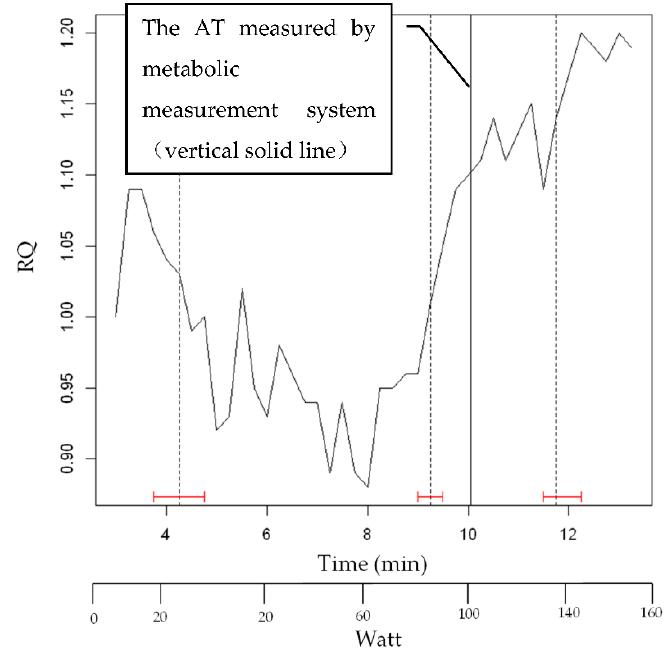
Figure 11. The results of strucchange results of RQ (subject K) after smoothing.